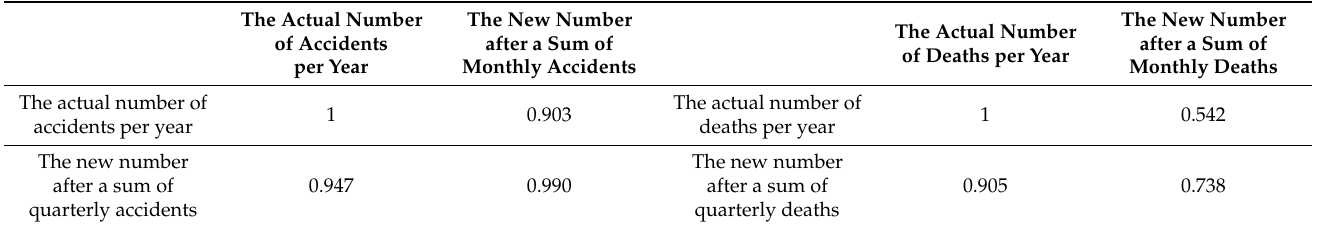
Table 1. Pearson correlation coefficient of newly generated data after trend decomposition and real